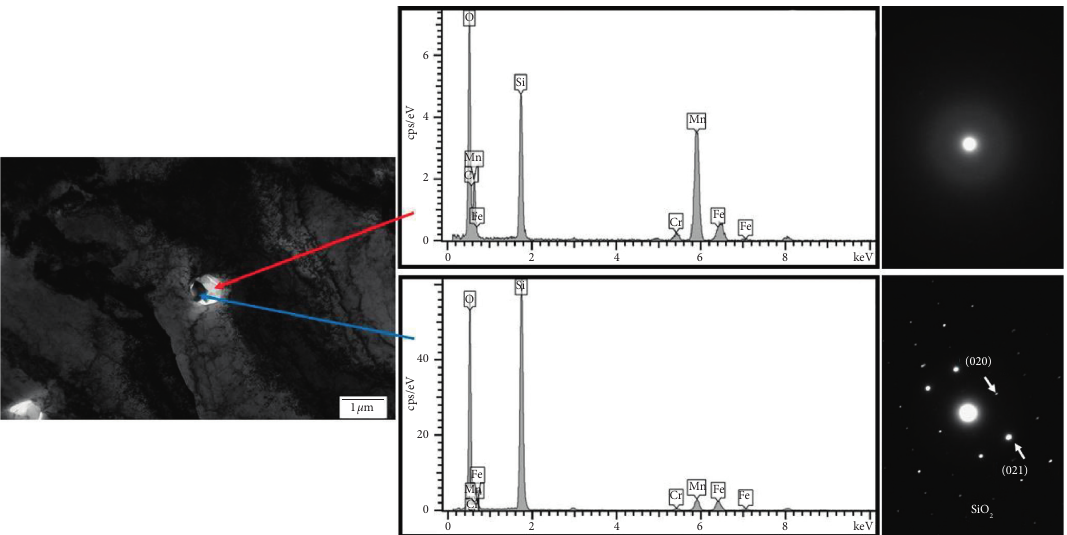
Figure 7: Morphology, EDS, and SAED of inclusions in the as-cladded 2.25Cr1Mo0.25V sample made by